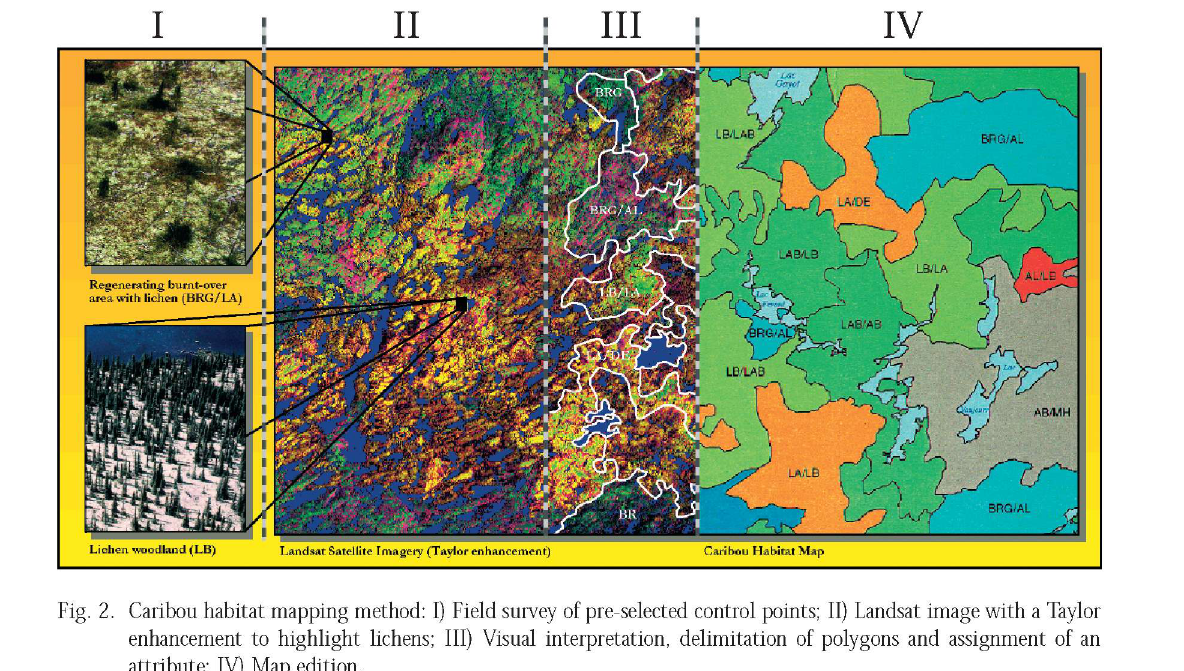
Fig. 2. Caribou habitat mapping method: I) Field survey of pre selected control points; II) Landsat image with a Taylor enhancement to highlight lichens; III) Visual interpretation, delimitation of polygons and assignment of an attribute; IV) Map